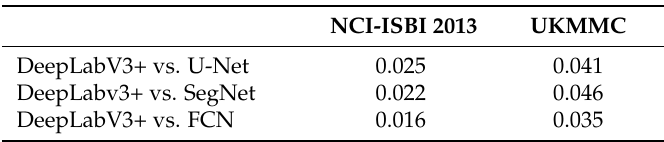
Table 3. P -value of DeepLabV3+ versus U-Net, SegNet and FCN for NCI-ISBI-2013 and UKMMC datasets, using patch-wise